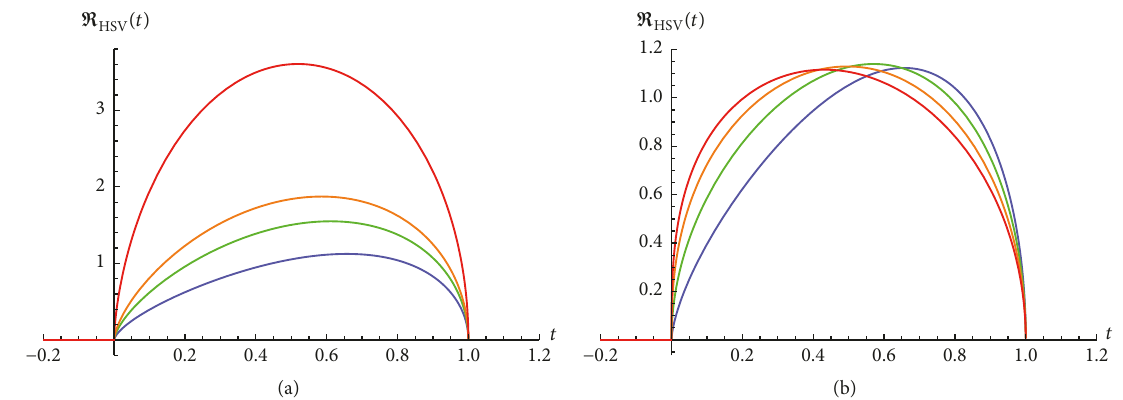
Figure 3: Time dependence of entanglement velocity for different values of 𝜃 and 𝑧 . The colors blue, green, red, and orange represent 𝜃 = {0.1,0.8,1.1,1.7} in part (a) and 𝑧 = {1.5,2,2.5, 3} in part (b), respectively. Common parameters are 𝑑 = 3 , 𝑡